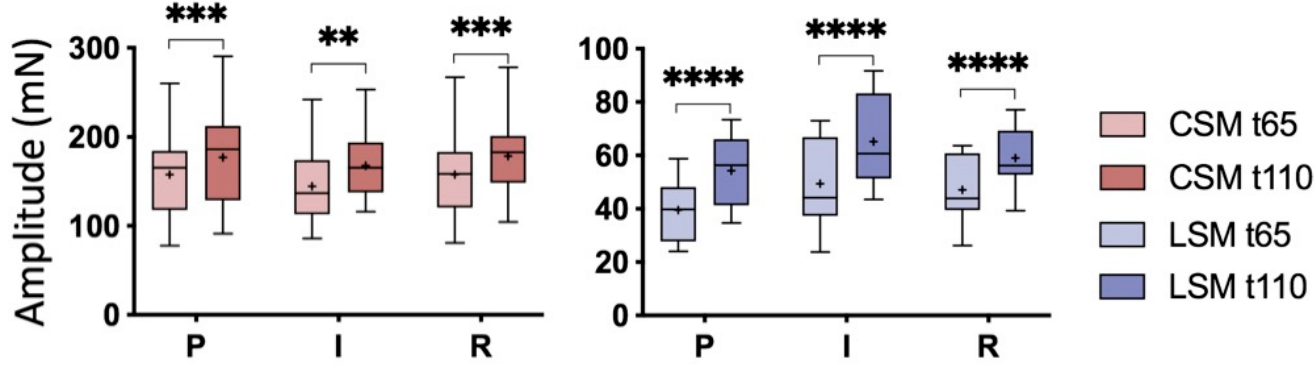
Figure 6. Box plot diagram of the nerve mediated contractile activity of jejunal circular smooth muscle (CSM) and longitudinal smooth muscle (LSM) of 12 horses during pre-ischaemia (P), ischaemia (I), and reperfusion (R) at t65. Significant differences between the time points (paired t -test) are marked with an asterisk (** p < 0.01; *** p < 0.001; **** p < 0.0001). The horizontal bar displays the median and the plus is the mean, the interquartile range is represented by the box and the minimum and maximum by the whisker plots.